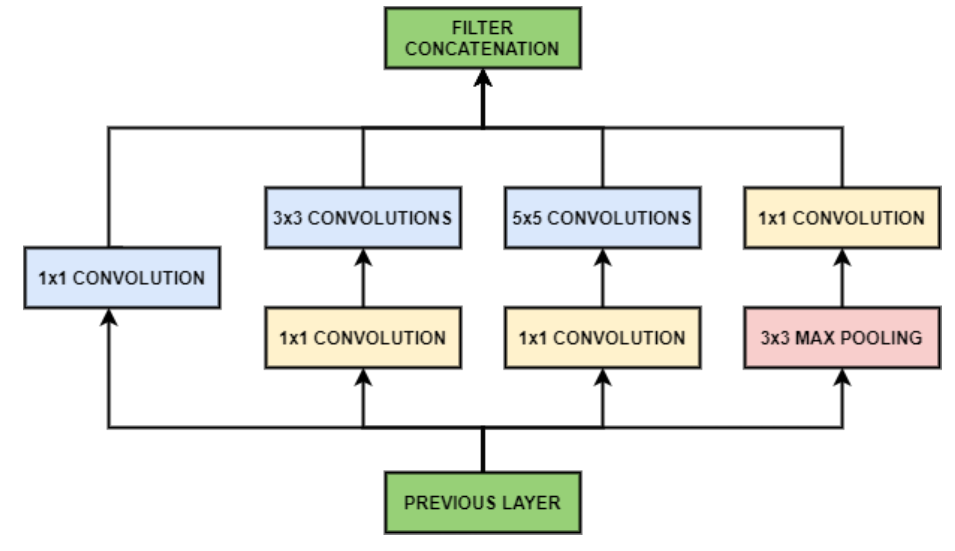
Figure 3. The architecture of a basic inception module